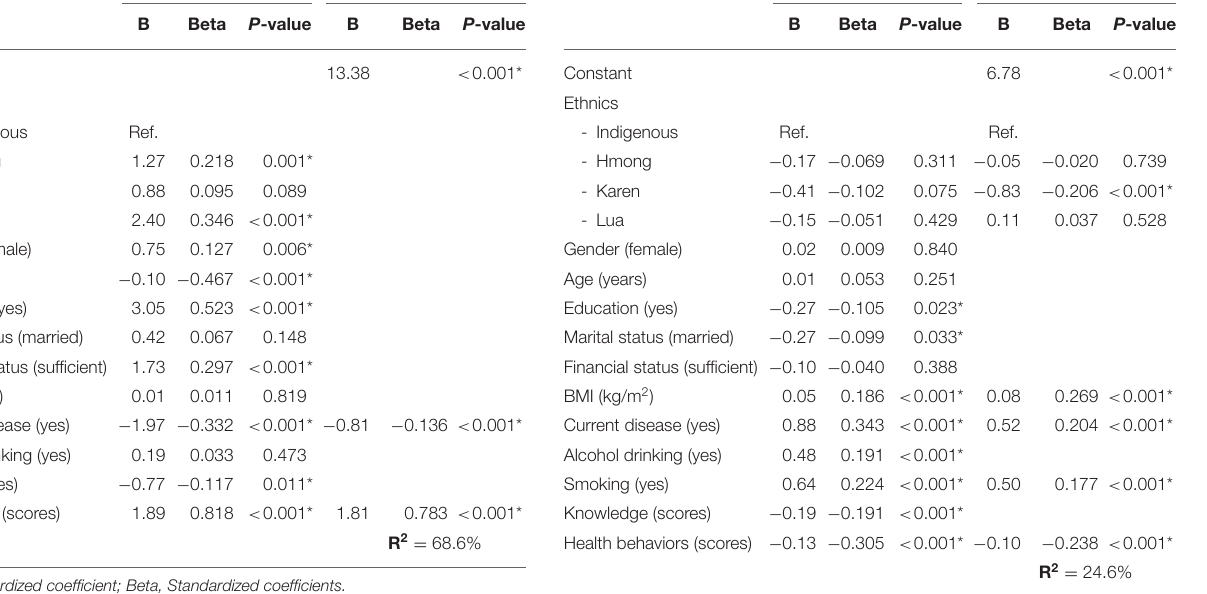
TABLE 3 | Factors associated with health behaviors in agricultural workers by linear regression ( n = 468). Factors